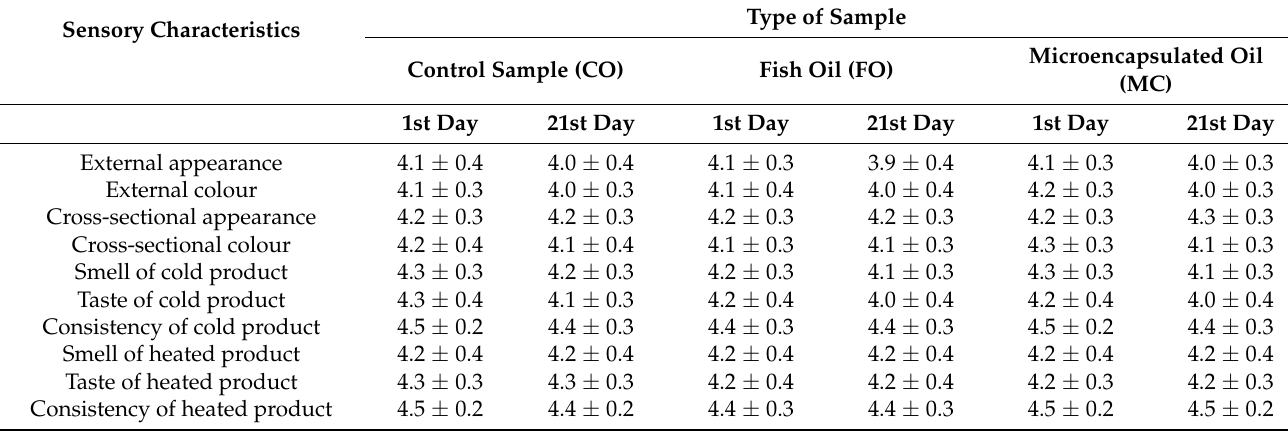
Table 2. The intensity of the sensory characteristics of the model systems of poultry sausages on the 1st and 21st days of